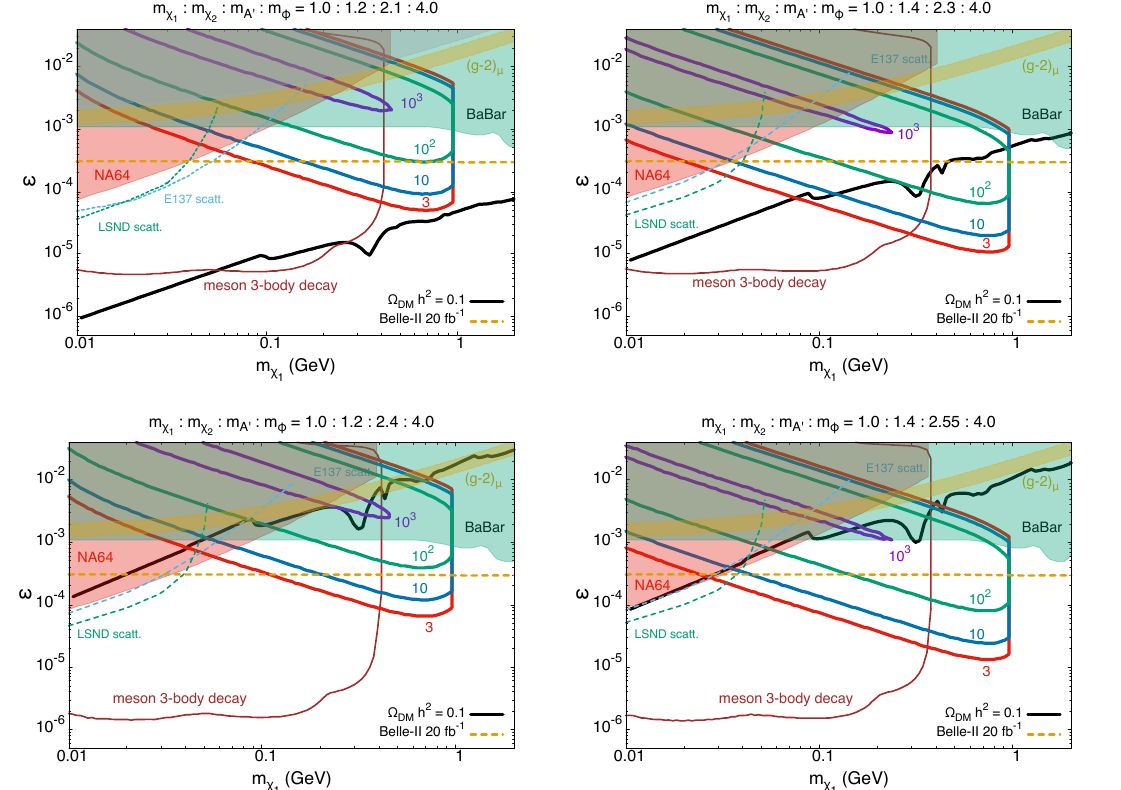
Figure 3 . Sensitivity region of the fermion inelastic dark matter decay. Red, blue, green and purple curves represent contours of the expected number of the signal events 3 , 10 , 10 2 and 10 3 , respectively. Black curve represents the relic abundance of the dark matter. Yellow dashed line is the projection of Belle-II sensitivity [49]. The filled color regions are excluded by NA64 (red) [24] and BaBar (green) [22], respectively. The brown curve corresponds to the sensitivity region for 3 signal events only from the 3 -body meson decays into γχ 1 χ 2